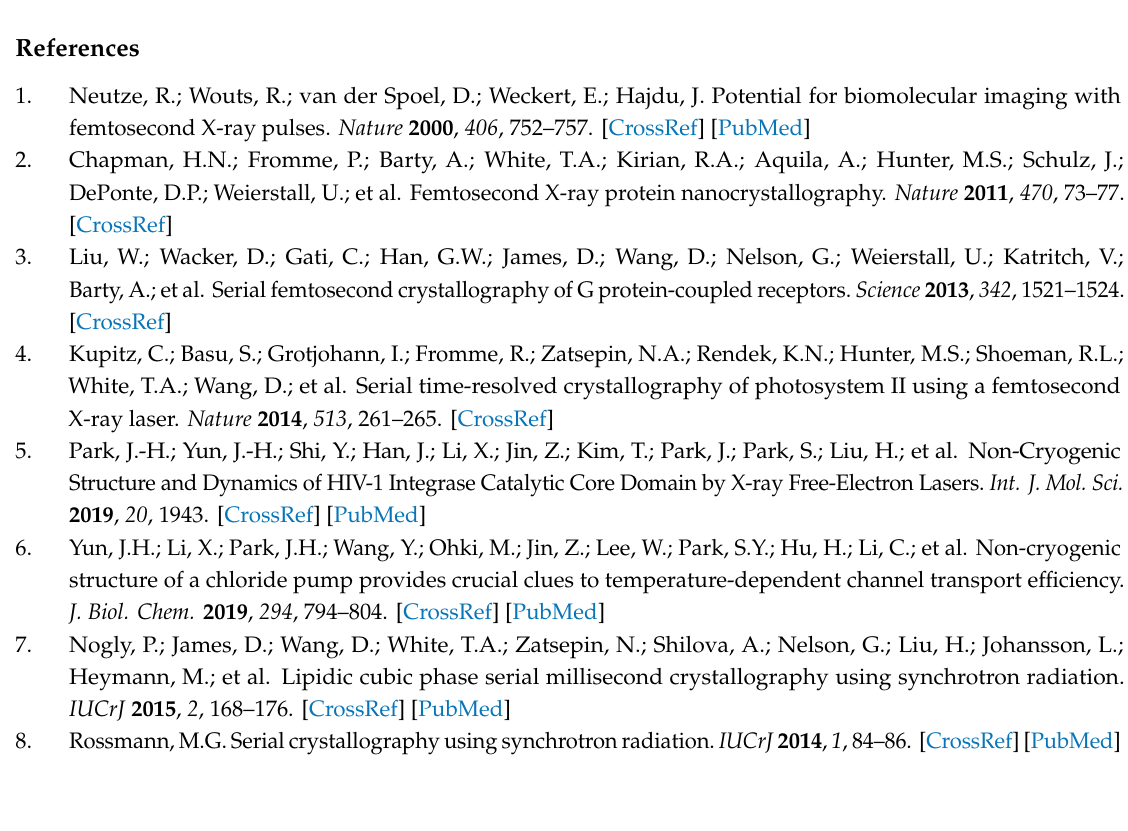
Table S1: Data collection and refinement